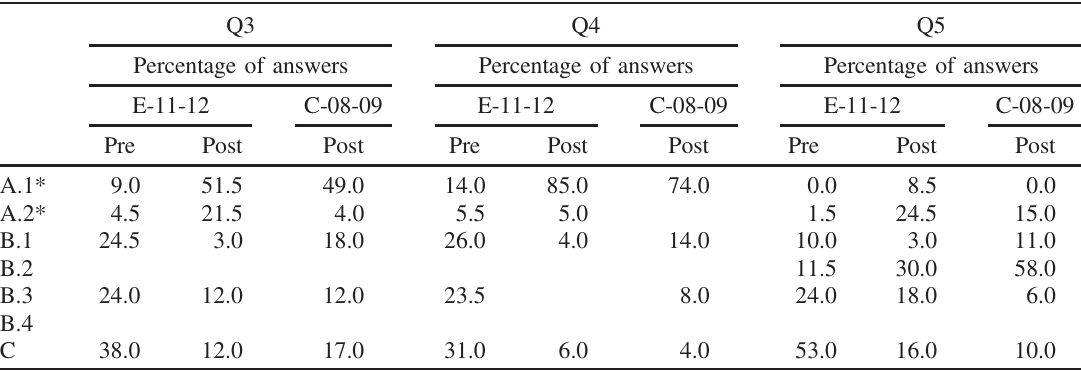
TABLE IV. Results for the Questions Q3, Q4, and Q5: (*) Correct answer. Experimental groups in Spring 11